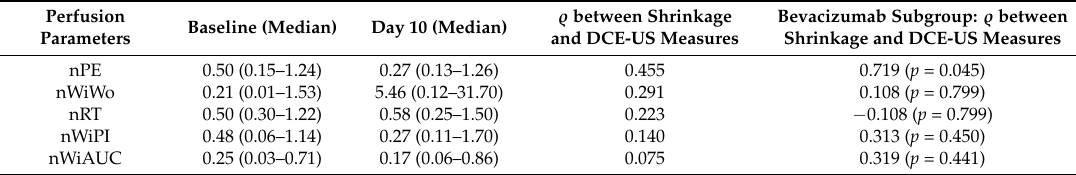
Table 2. Perfusion parameters and correlations co-efficient ( (cid:36) ) for each parameter and correlation to tumor